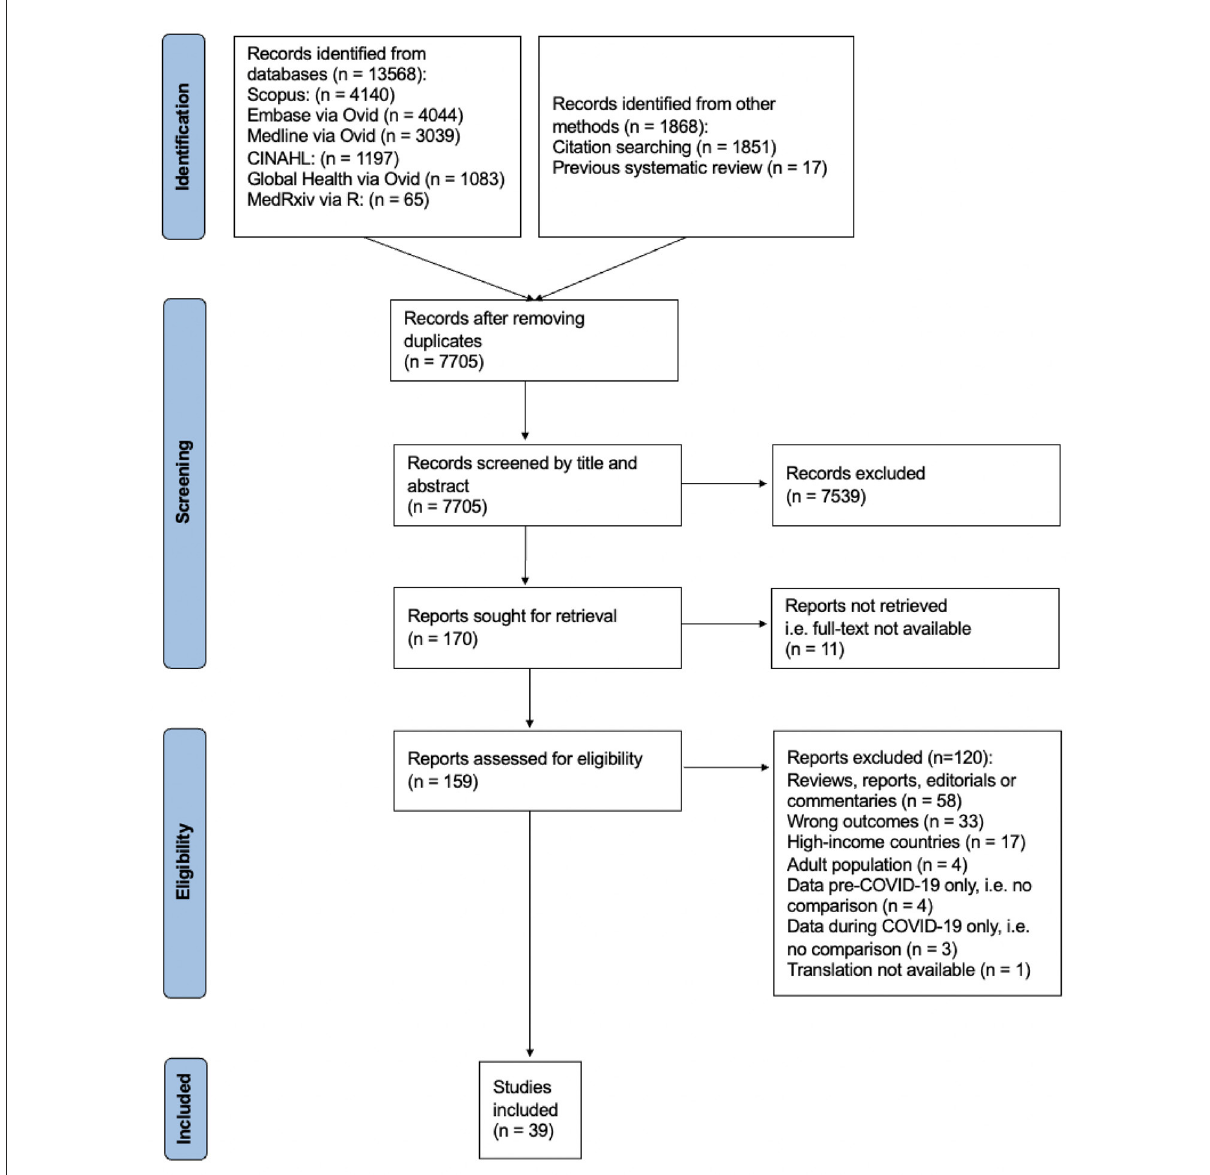
FIGURE1 PRISMA flow diagram summarizing identification, screening, exclusion, and inclusion of studies (see Supplementary Figure 1 for detailed PRISMA 2020 flow diagram).